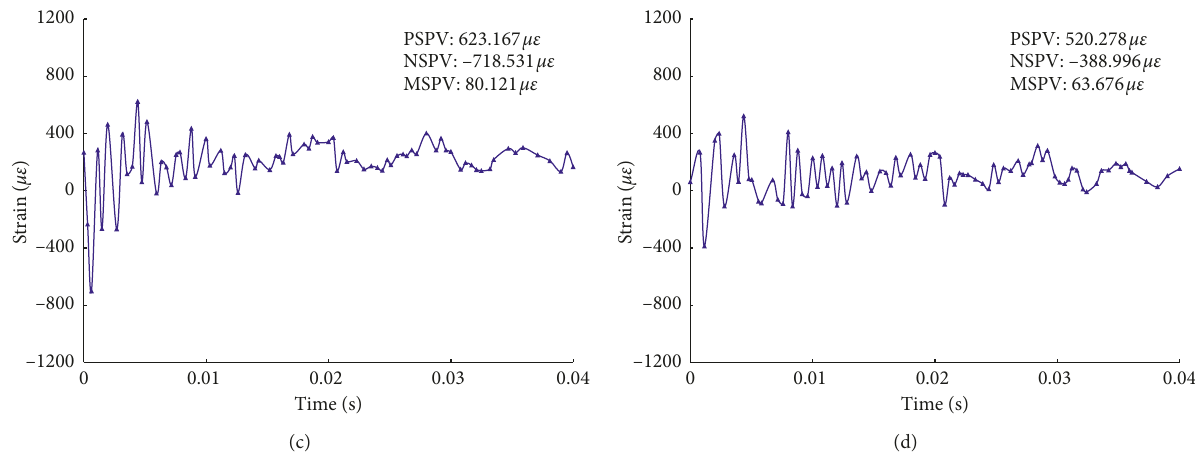
Figure 6: Waveform curve of dynamic strain for #2 test model: (a) #E2-1 test point, (b) #E2-2 test point, (c) #E2-3 test point, and (d) #E2-4 test point.